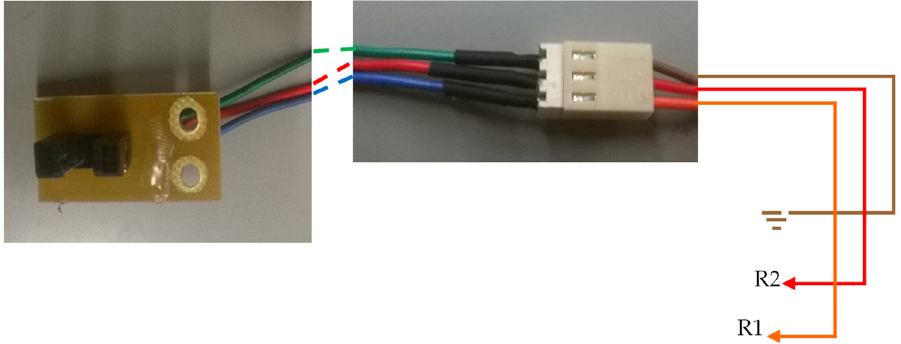
Figure 15. Image of the optical sensor and plug connection, connecting the board to the electrical circuit.